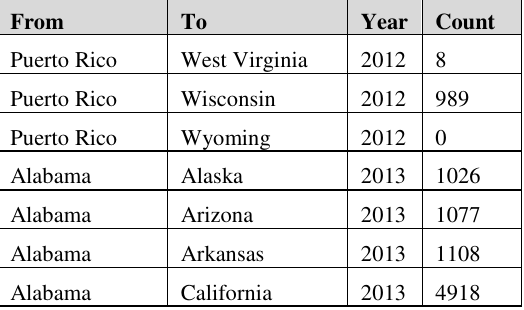
Figure 1 System components and their functions